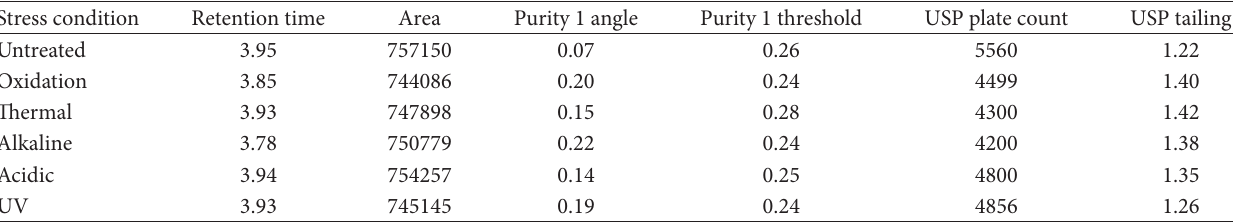
T 8: Speci�city data for stress conditions.